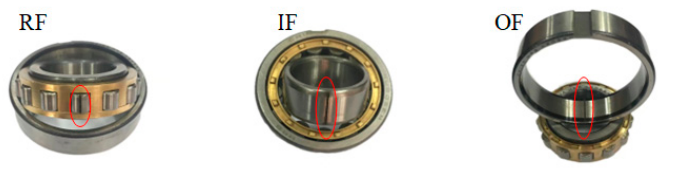
Figure 7. Ball bearing data testing platform.